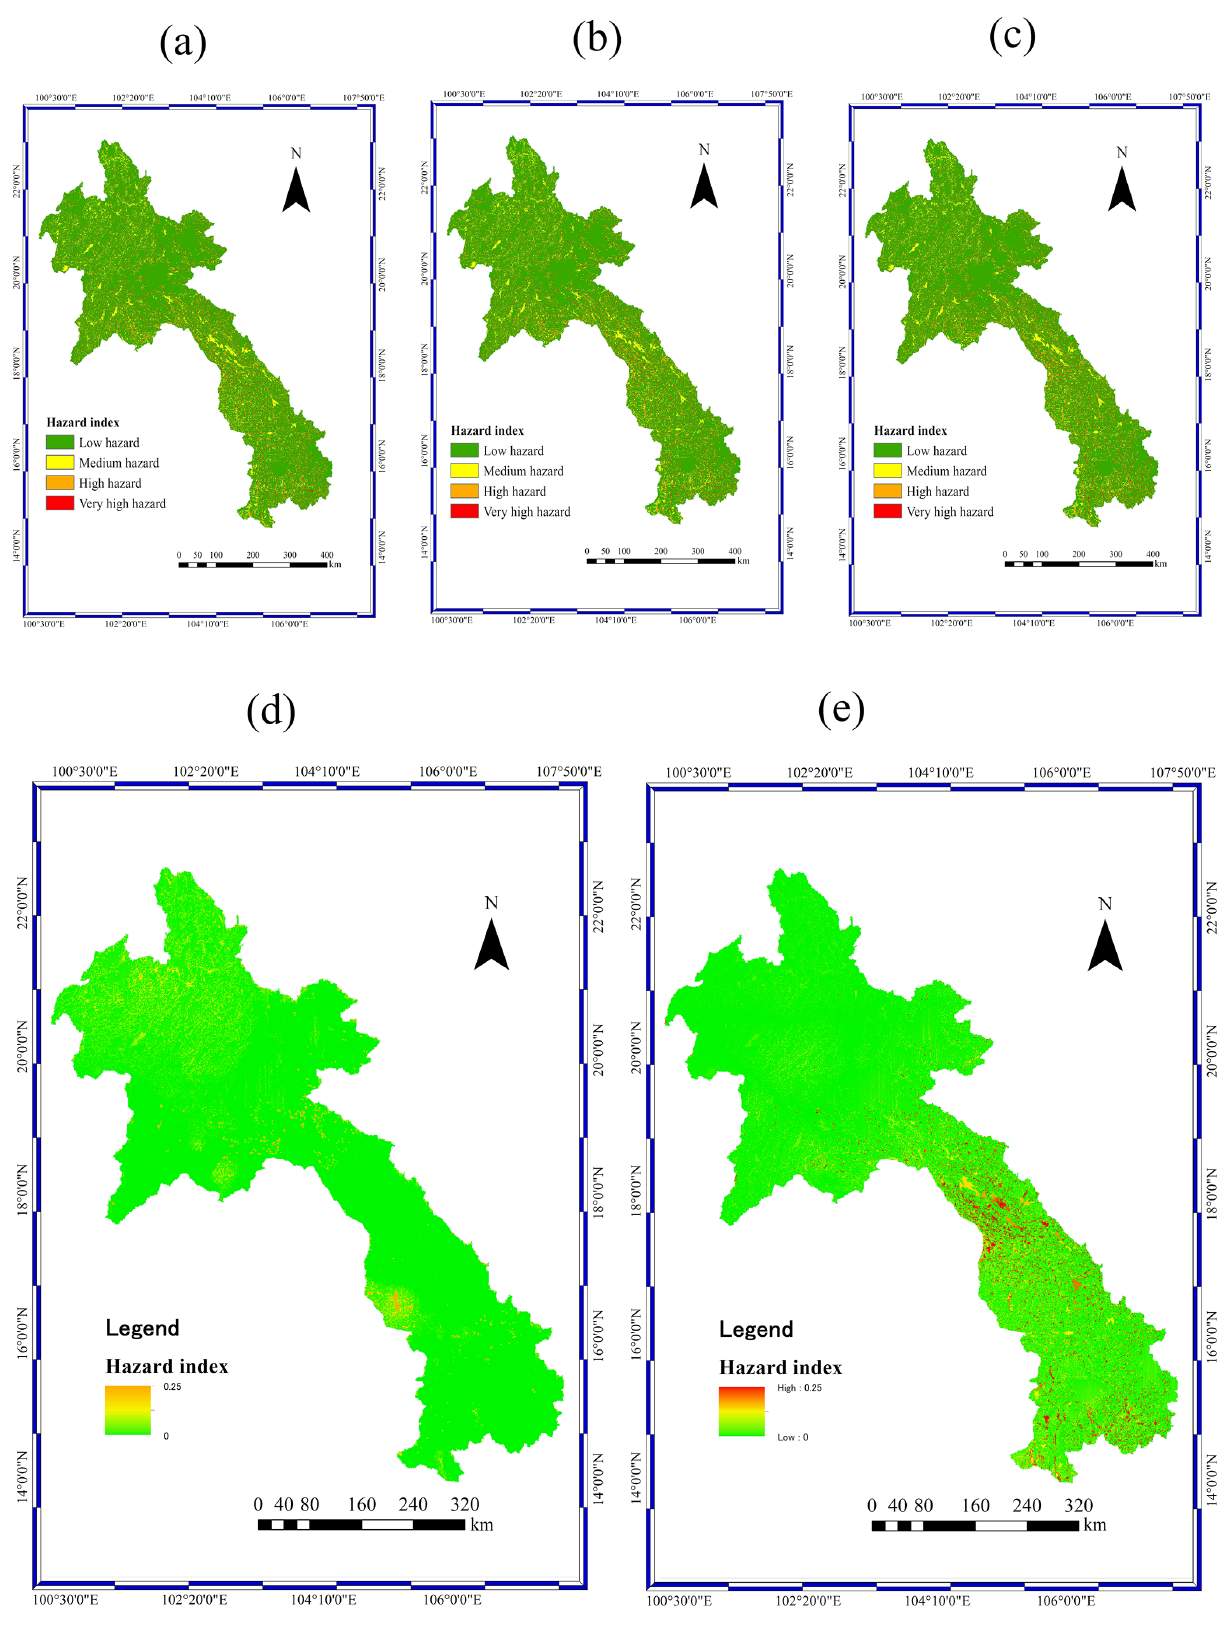
Figure 6. Integrated hazard maps for the 100-year return period under scenarios (a) RCP2.6, (b) RCP4.5, and (c) RCP8.5 and the difference in hazard index between scenarios (d) RCP4.5 and RCP2.6 and between scenarios (e) RCP8.5 and RCP4.5 during the near